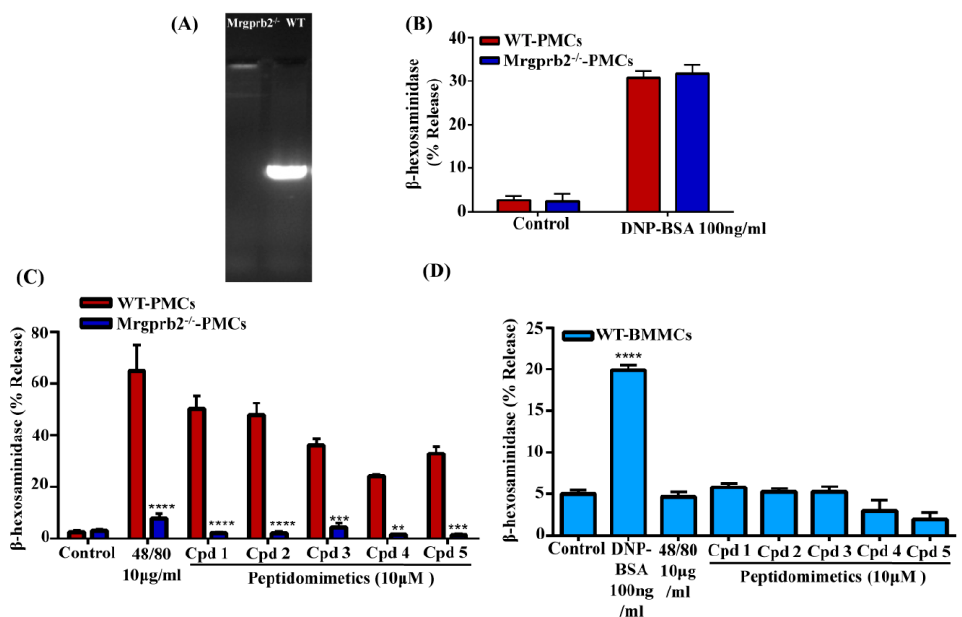
Figure 6. smHDPMs induce degranulation in PMCs via Mrgprb2. (A) Genotyping of wild-type (WT) and Mrgprb2 - / - by PCR using Mrgprb2-specific primers. (B) PMCs isolated from WT and Mrgprb2 - / - mice were exposed to IgE (1 µg/ml, 16 h) and then stimulated with antigen (DNP-BSA, 100 ng/ml, 30 min) and β -hexosaminidase release was determined. (C) PMCs were stimulated with compound 48/80 (10 µg/ml) or smHDPMs (Cps 1–5, 10 µM) for 30 min and β -hexosaminidase release was determined. (D) BMMCs were exposed to IgE (1 µg/ml, 16 h) and stimulated with antigen (DNP-BSA, 100 ng/ml), 48/80 (10 µg/ml), smHDPMs (10 µM) for 30 min and β -hexosaminidase release was